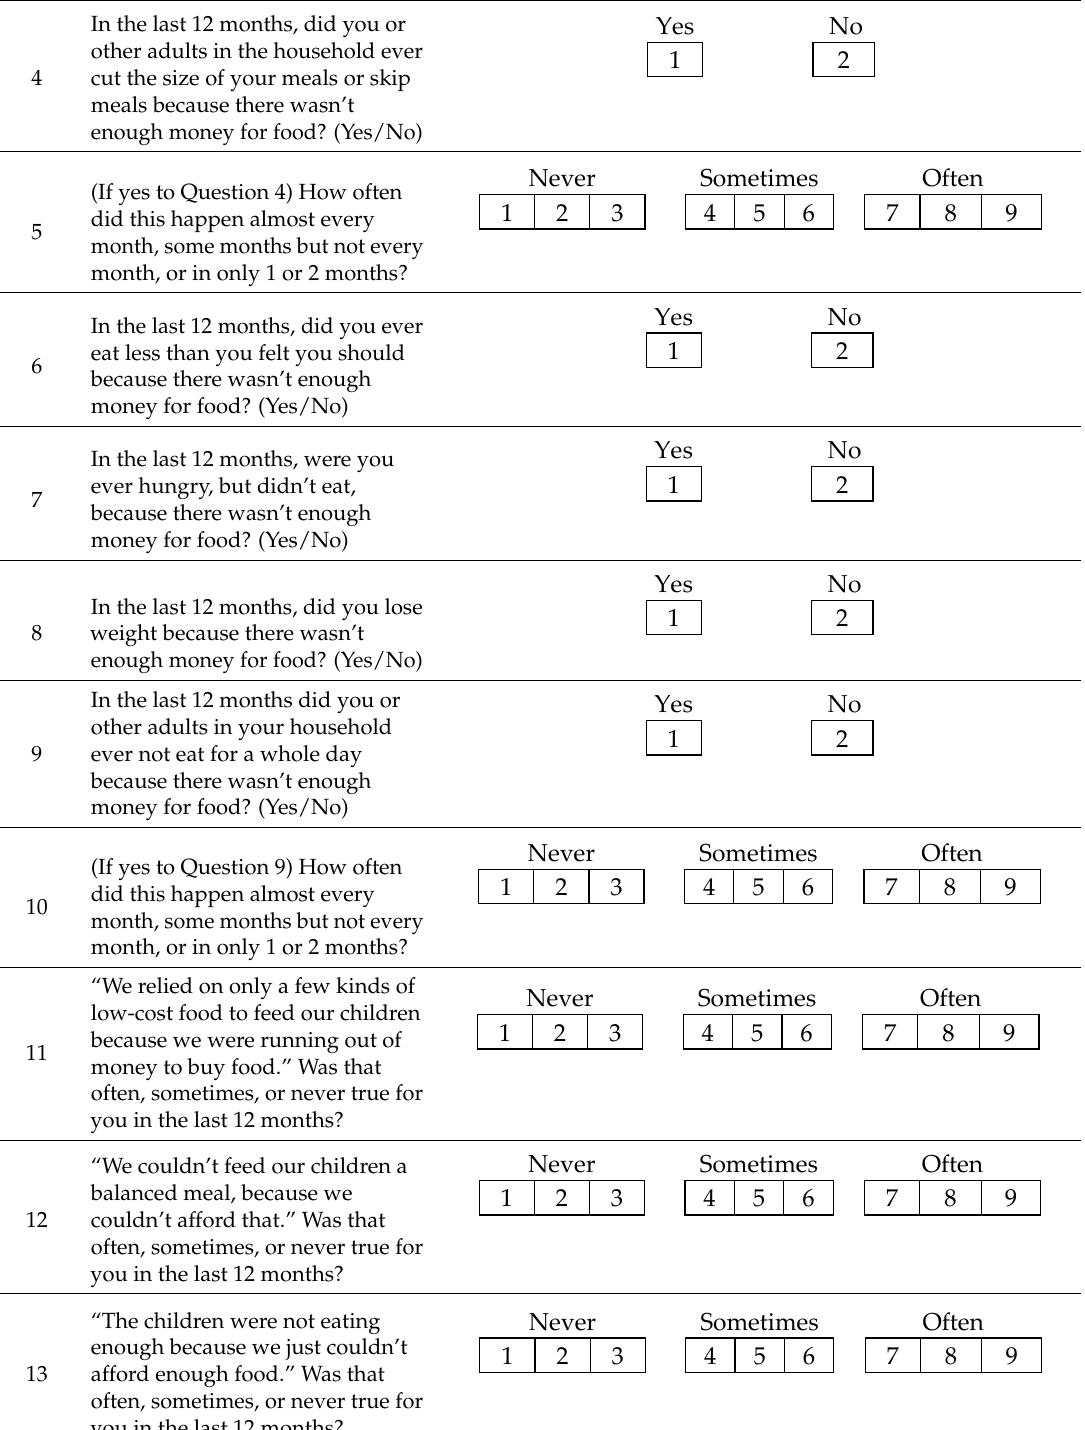
Table A1. 18-Question Core Food Security Module. 1